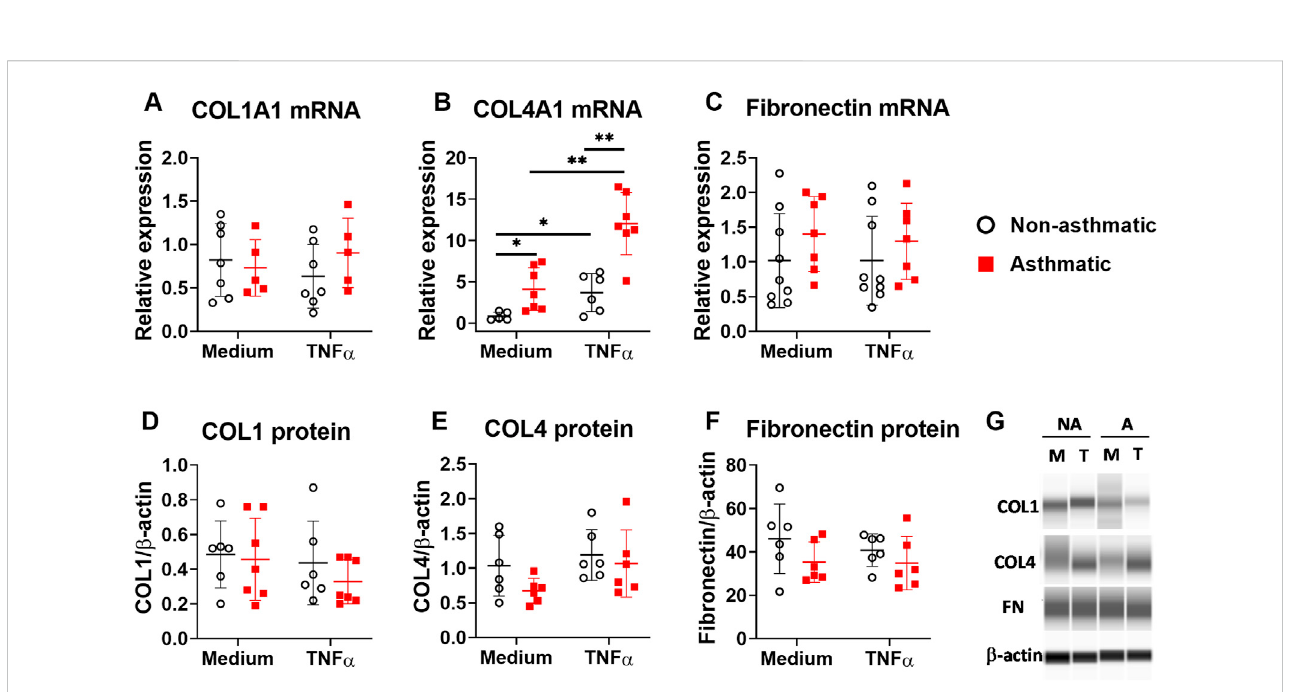
FIGURE 2 ECM expression in asthmatic and non-asthmatic human lung fi broblasts. Serum-starved fi broblasts were cultured with medium or TNF α (20 ng/ml) for 24 h or 3 days. RNA was extracted from the cells cultured for 24 h. Cell lysates were made after 3-day culture. Gene expression was determined by quantitative PCR (A – C) . The levels of ECM protein in the cell lysates were determined by WES and normalized to the expression of β -actin (D – F) . RepresentativeWESimagesareshownin (G) (NA:non-asthmatic.A:asthmatic.M:medium.T:TNF α ).Normalizeddataareshownasmean±SDfromN= 5 – 7 patient samples. Each dot represents one patient sample. * indicates signi fi cant difference p < 0.05. ** indicates signi fi cant difference p <